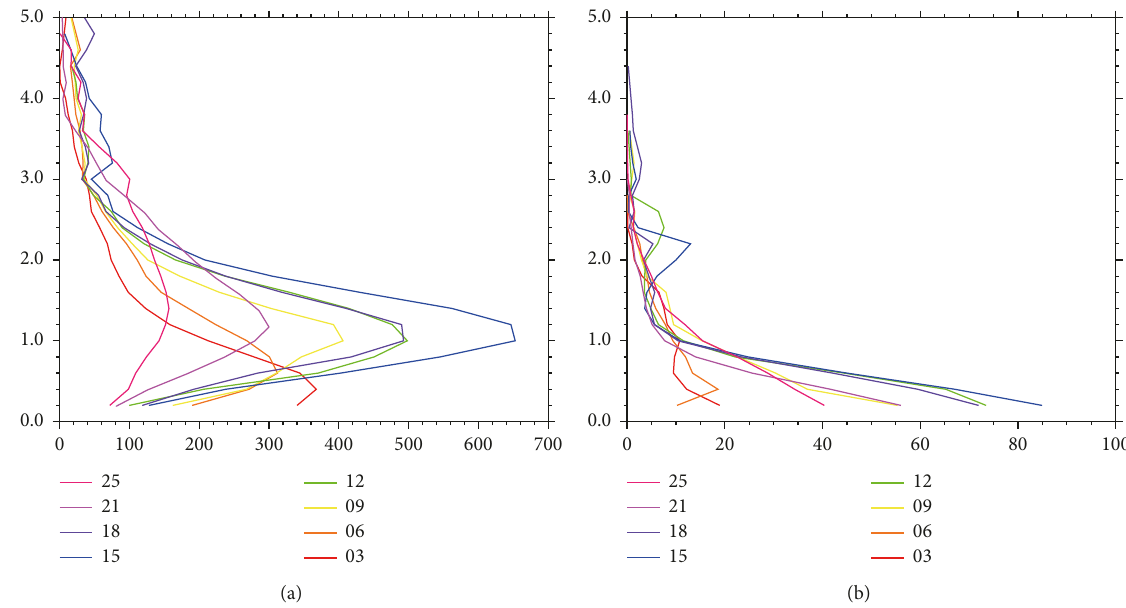
1 ) in the rainstorm area at various times 03–24 h from 0300 kg · −